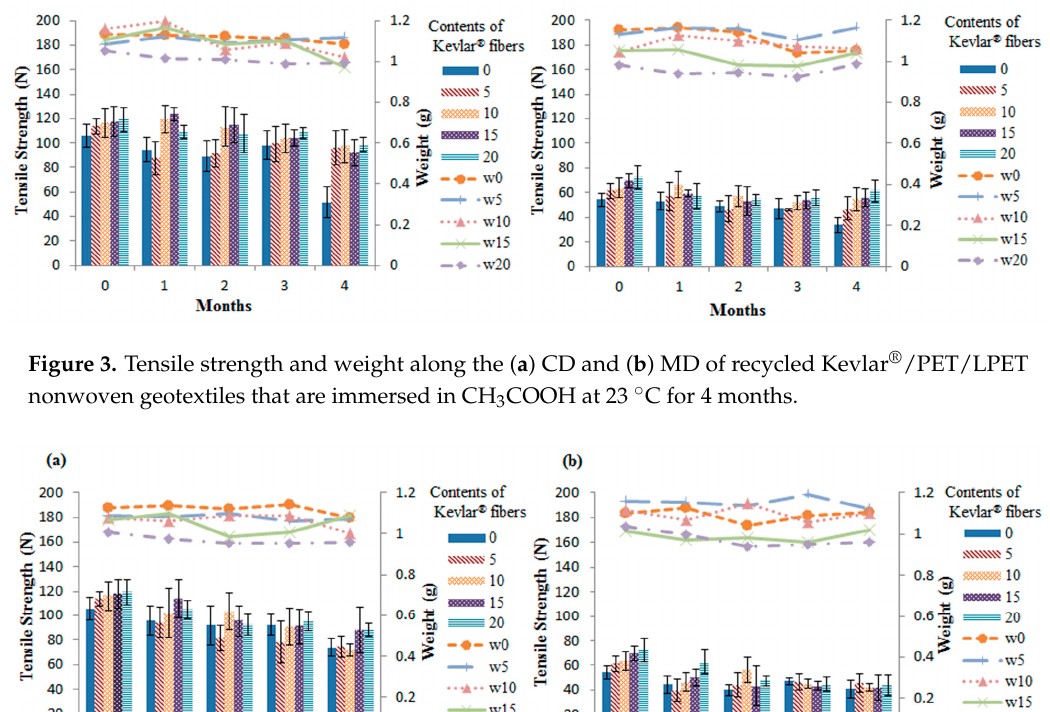
nonwoven geotextiles that are immersed in H 2 O at 50 °C for 4 months .